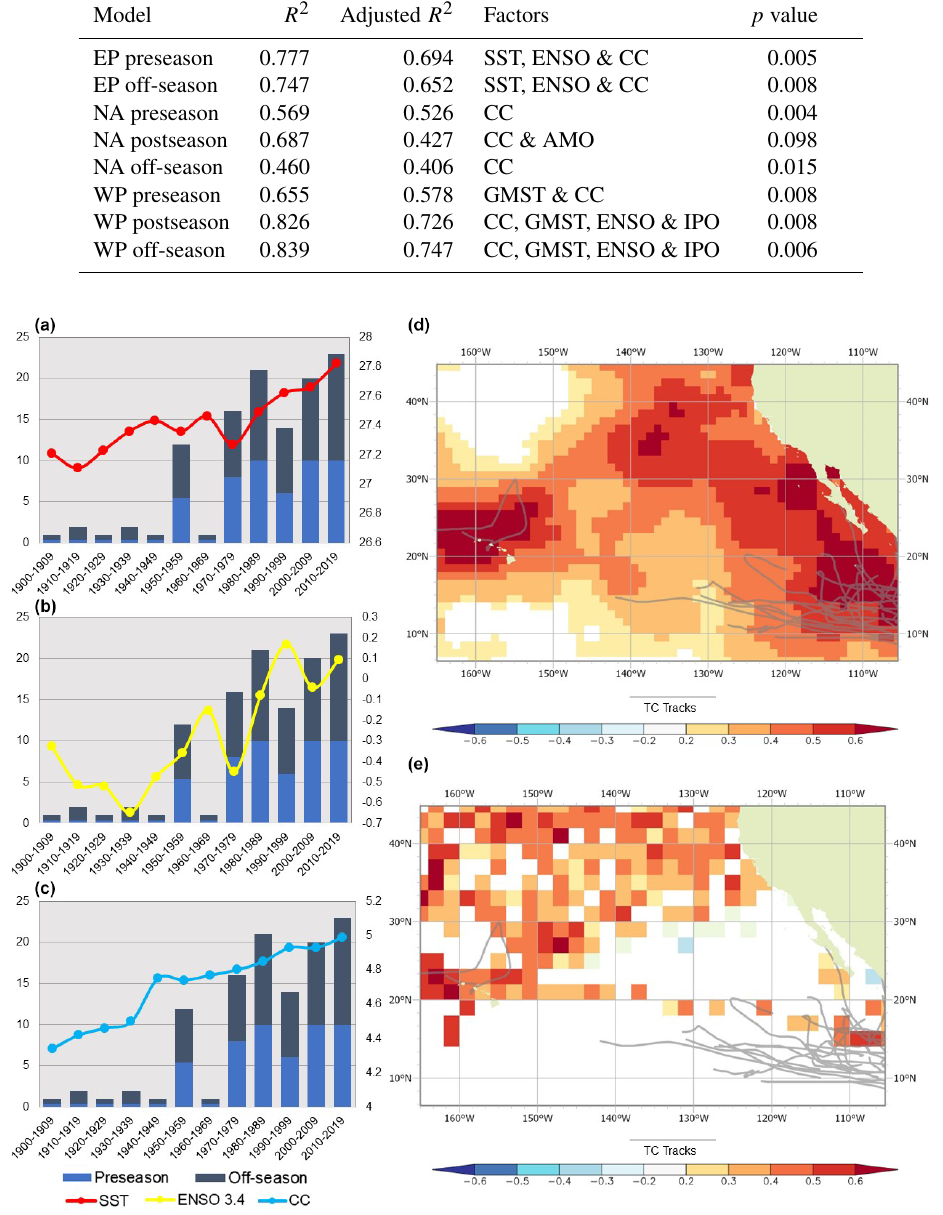
Figure 3. Decadal TC counts for the EP off-seasons and decadal average SSTs (a) ; decadal TC counts for the EP off-seasons and decadal average Niño 3.4 (b) ; decadal TC counts for the EP off-seasons and decadal average correlation between time and December–May-averaged CC (c) ; correlation between time and December–May-averaged SST (C ◦ ) and the off-season TC tracks for the 1900–2019 period (d) ; and correlation between time and December–May-averaged CC (oktas) and the off-season TC tracks for the 1900–2019